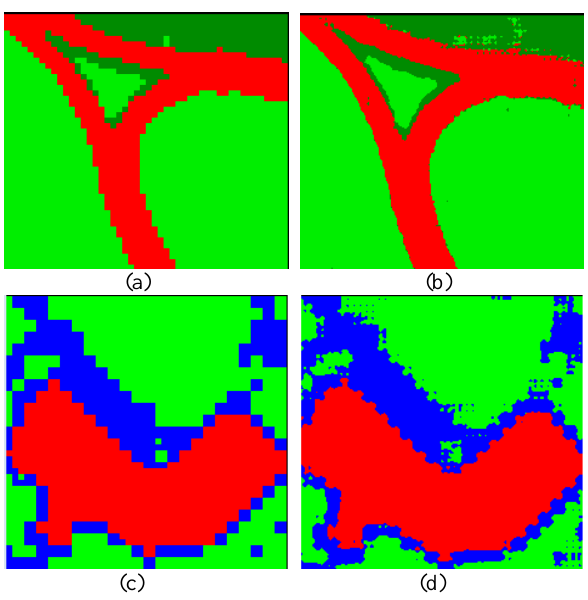
Figure 7. Evaluation of the proposed SRM method on real satellite imagery: (a, c) hard classified map of the Quickbird and Landsat ETM+ images, (b, d) finer spatial resolution map produced by the SRM algorithm of the Quickbird and Landsat image ( Z=5, M=8